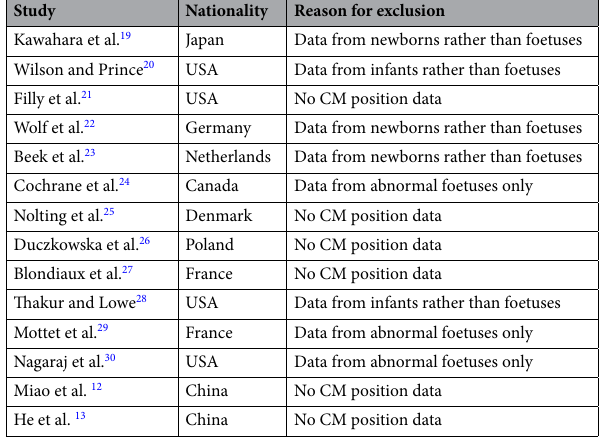
Table 1. Reasons for excluding the articles from further